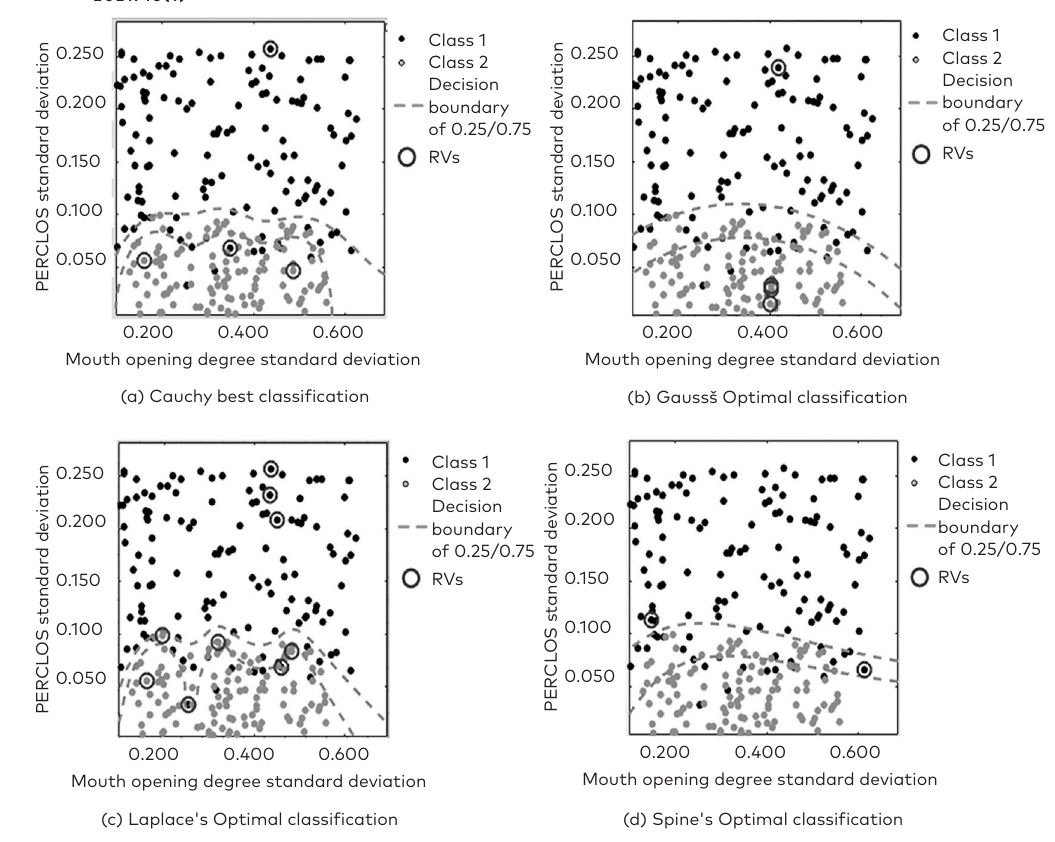
Figure 8. Classification results obtained using different kernel functions; Note: Class 1 represents the fatigue state, Class 2 represents the